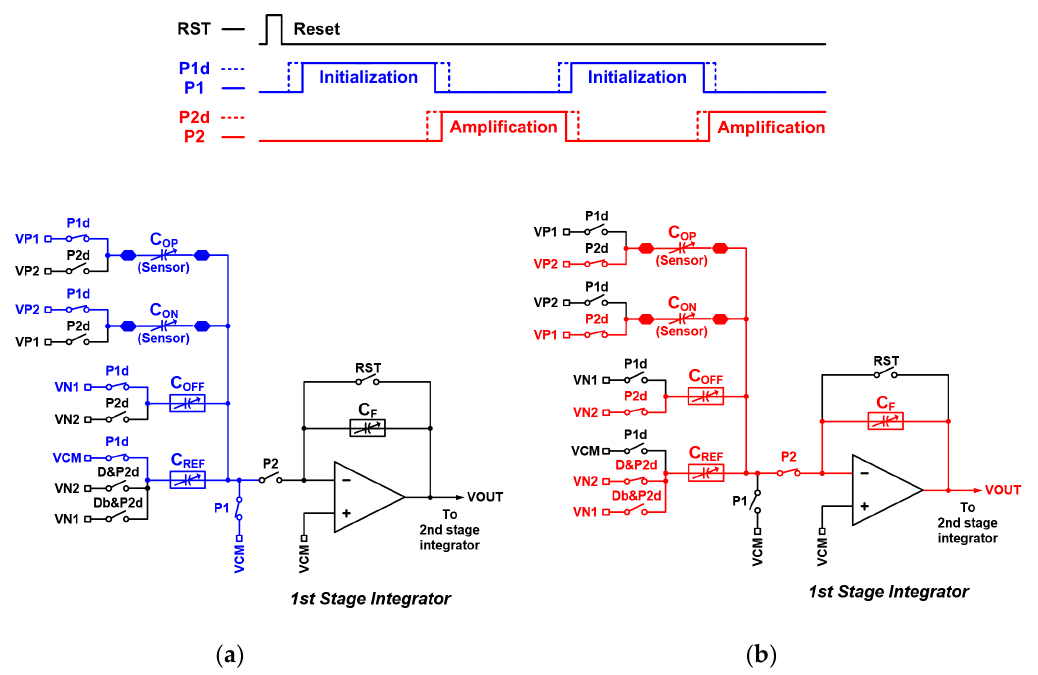
Figure 4. Detailed operation timing of the integrator in the delta-sigma CDC. ( a ) Initialization phase; ( b ) Amplification phase.